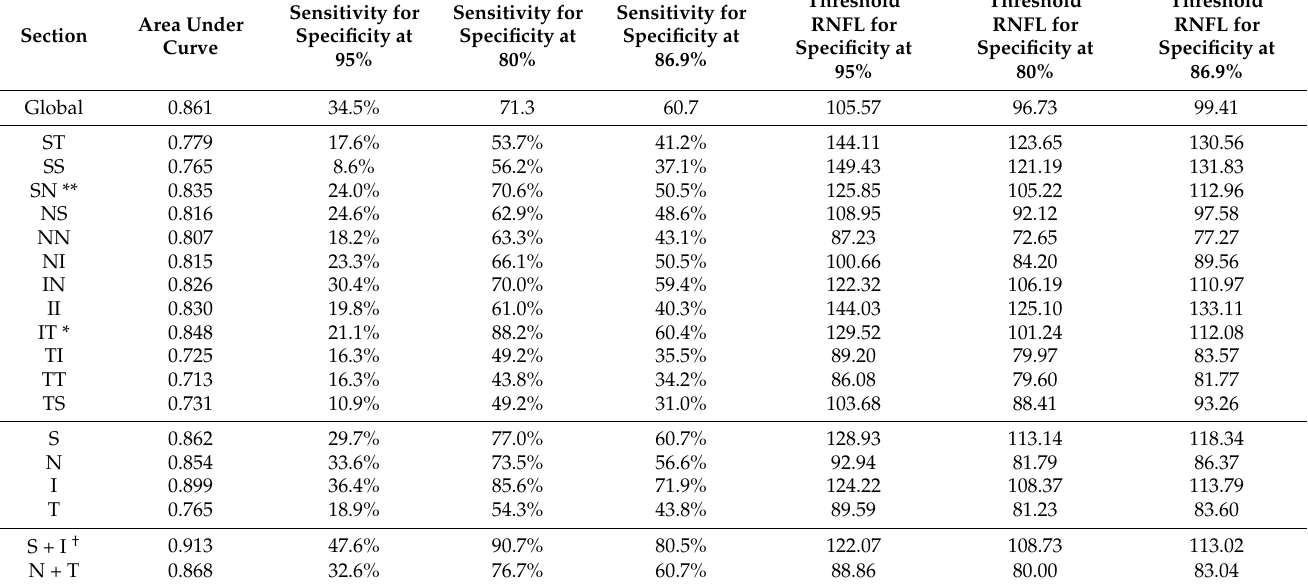
Table 5. Summary of ROC analysis based on section-wise predicted RNFL thicknesses and localized mean over superior (S), nasal (N) inferior (I), temporal (T), superior plus inferior (S + I), and nasal plus temporal (N + T). * Refer to the highest sensitivity and ** to the second highest sensitivity for specificity at 80% among 12 subsections. † Refer to the best scored overall